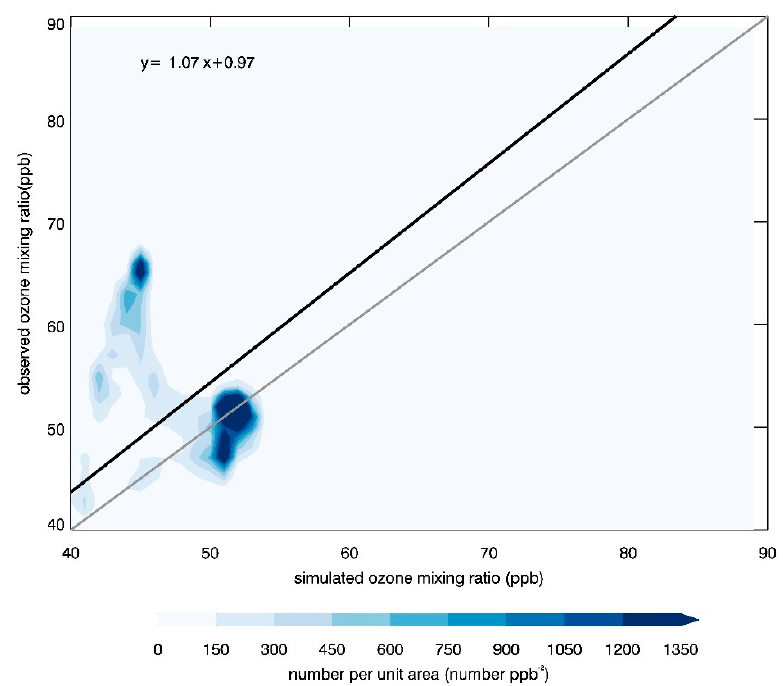
Figure 5. The scatter plot of observed and simulated ozone. The top and bottom panels represent the standard run vs. the observations and the control run vs. the observations, respectively. The black lines are the linear regression fitting function, and the gray lines are linear regression functions.